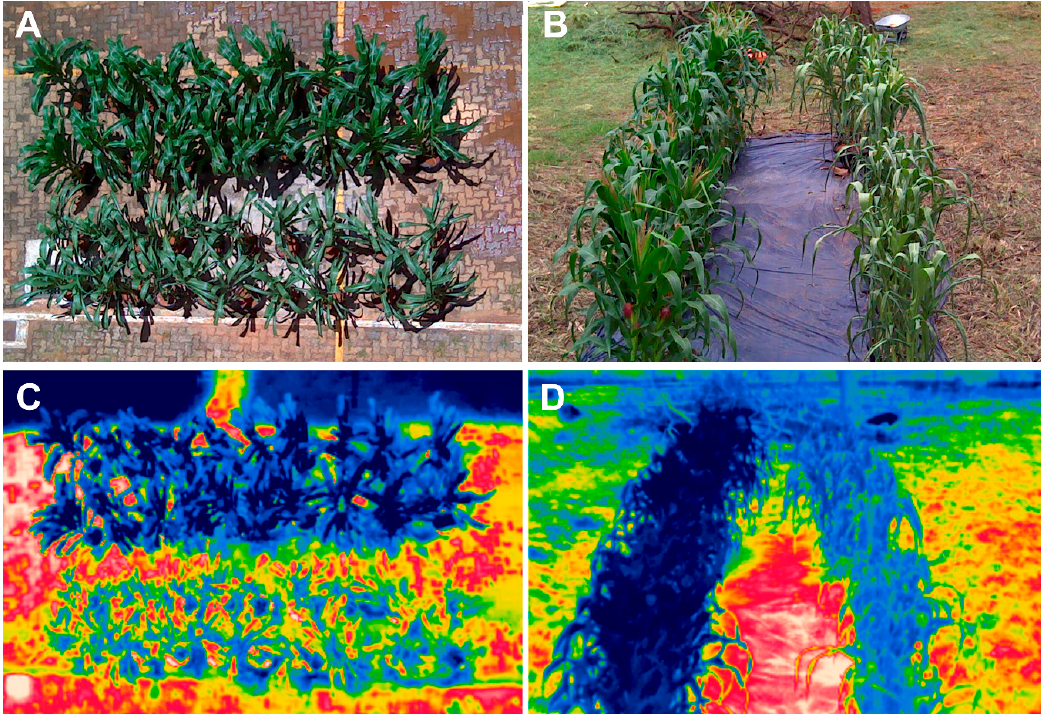
Figure 1. ( A , B ) RGB and ( C , D ) thermal images of maize plants taken on the 4 th ( A , C ) and 12 th ( B , D ) day of drought stress. The upper ( A , C ) and left hand side ( B , D ) rows of dark green (RGB) and dark blue (thermal) are controls, while the lower and right hand side rows of pale green and light blue are drought-stressed plants.